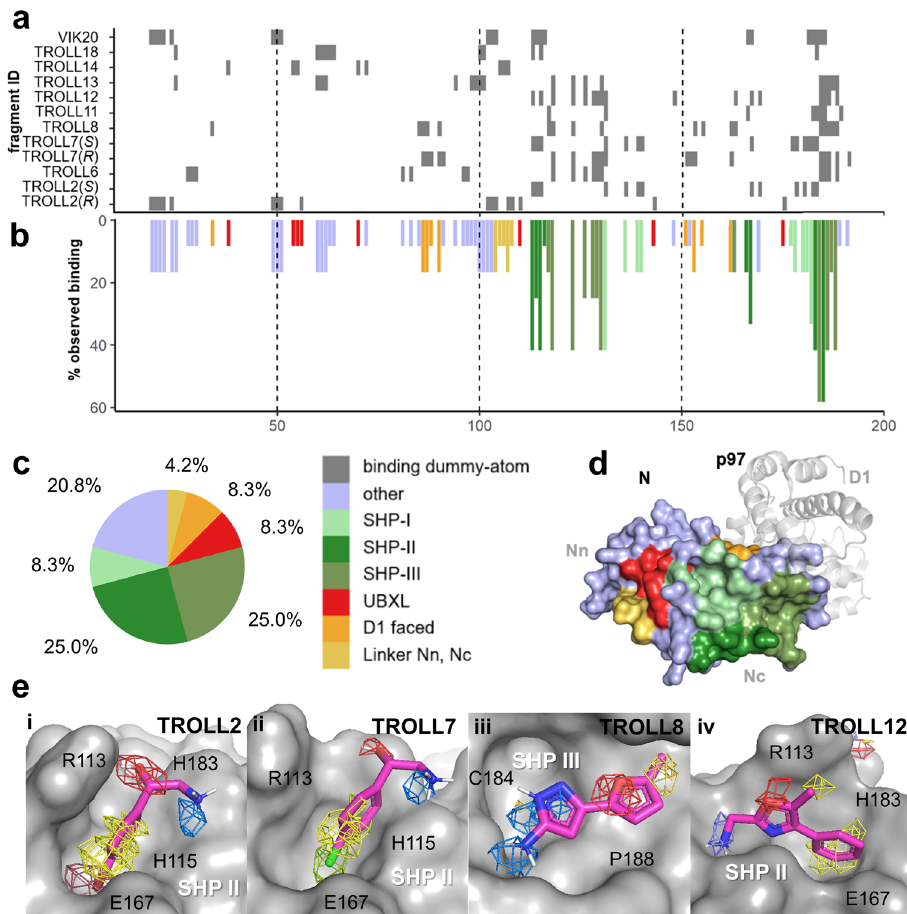
Fig. 5 Results of mixed-solvent MD simulations. The 10 hit fragments of Table 1 were simulated, including both enantiomers of TROLL2 and TROLL7. a Binding-site residue map. Grey rectangles specify amino acids along the primary sequence (horizontal axis) which are in the vicinity (<6 Å from the dummy atom) of the two sites with highest occupancies of the corresponding fragment. b Relative propensity of observed binding interactions. The bars indicate in how many of the 12 individual simulations the residue was identi fi ed as binding-site residue according to panel a , using the color code of panel c . c Pie chart with the distribution of the two sites with highest occupancy for each fragment across the N-domain surface ( N = 24). d Location of the corresponding regions on the surface, color-coded according to the pie chart. e Illustration of fragments for which a binding mode could be postulated from the mixed-solvent simulations: i TROLL2 and ii TROLL7 in the SHP II site; iii TROLL8 in a cavity near the SHP binding region (SHP III); and iv TROLL12 in SHP II, in a different orientation compared to TROLL2 and TROLL7. A representative pose in stick representation as well as the occupancies of selected heavy atoms in mesh representation are shown. The poses were selected as described in the Materials and Methods